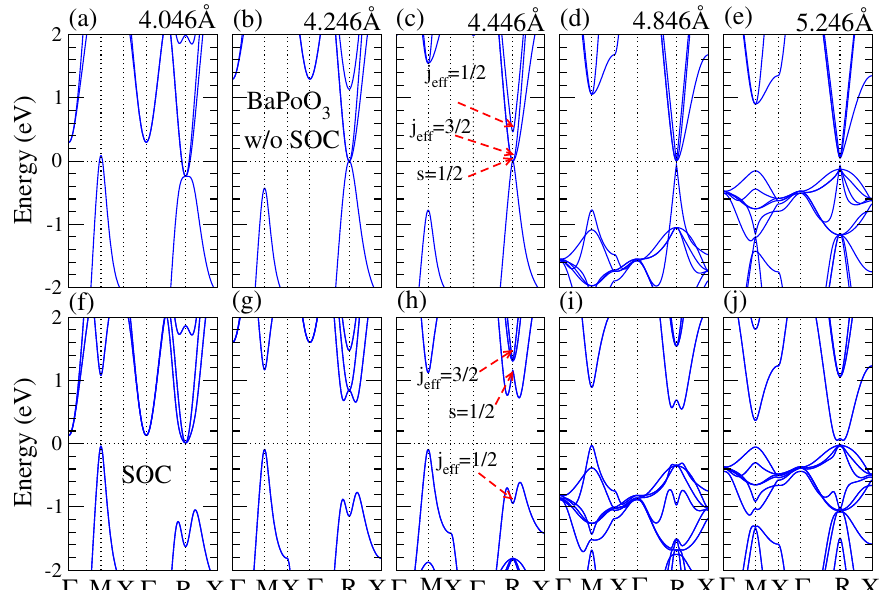
Figure 4. Calculated electronic band structures of BaPoO 3 as a function of the lattice constant without (upper panel) and with (bottom panel) SOC. Lattice constant for ( a , f ) is 4.046 Å; ( b , g ) 4.246 Å; ( c , h ) is 4.446 Å; ( d , i ) is 4.846 Å; ( e , j ) is 5.246 Å. The external pressure induced by the change of lattice constant is from 60 GPa to − 20 GPa as shown in Figure 3b. The Fermi level is shifted to zero as a reference. Without SOC effect, the BaPoO 3 perovskite is a normal metal and the band contributions at R point near the Fermi level is the same, except ( e ). When the SOC is taken into account, the band inversion occurs at lattice constant from 4.046 Å to 4.846 Å. The energy for the lowest unoccupied band is decreased when the lattice constant is decreased or increased, which results in a decrease in